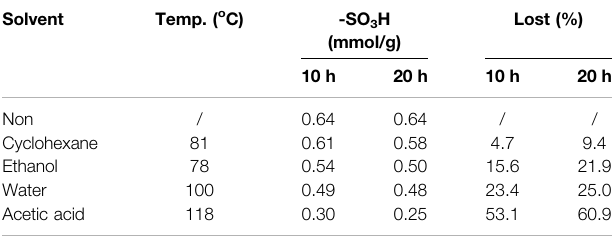
TABLE 3 | Stability of AC-Ph-SO 3 H in different solvents Solvent Temp. ( o C)